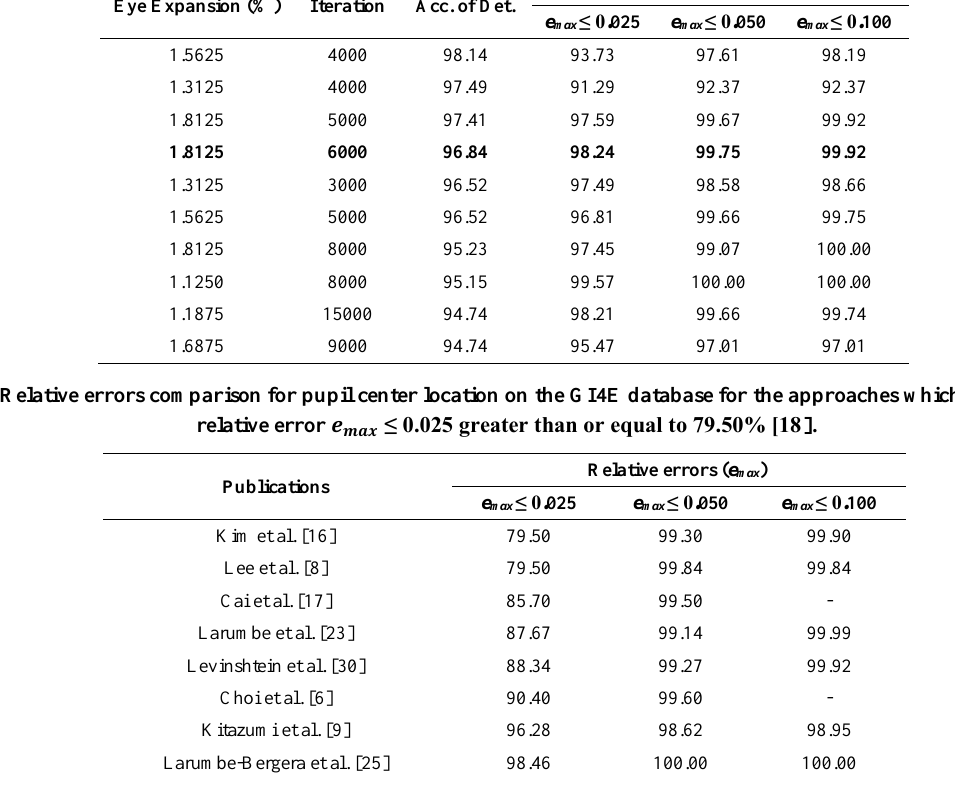
Figure 5. Comparison of the detectors' loss curves trained from the datasets with α = 3 and β between 1.1250 to 1.8175 with a 0.0625 increment Table 2. Comparison of experiment results between the ordinary detector and several detectors produced by training with our datasets. Acc. of det. is the accuracy of detection Eye Expansion (%) Iteration Acc. of Det.